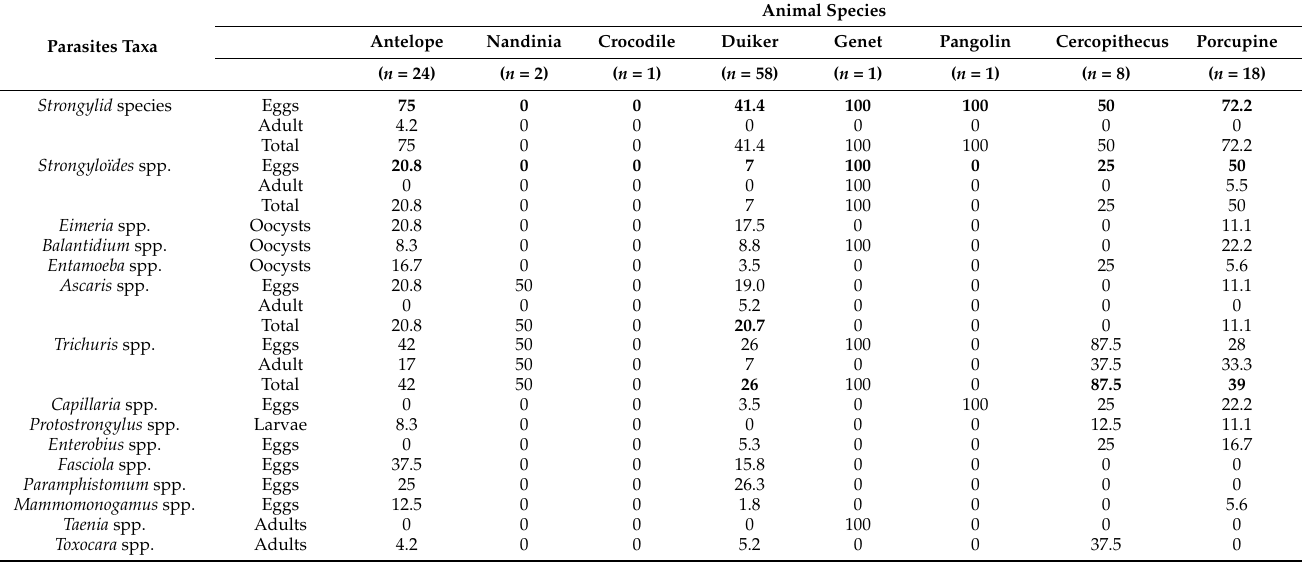
Table 3. Parasite infestation rates in percentage by animal